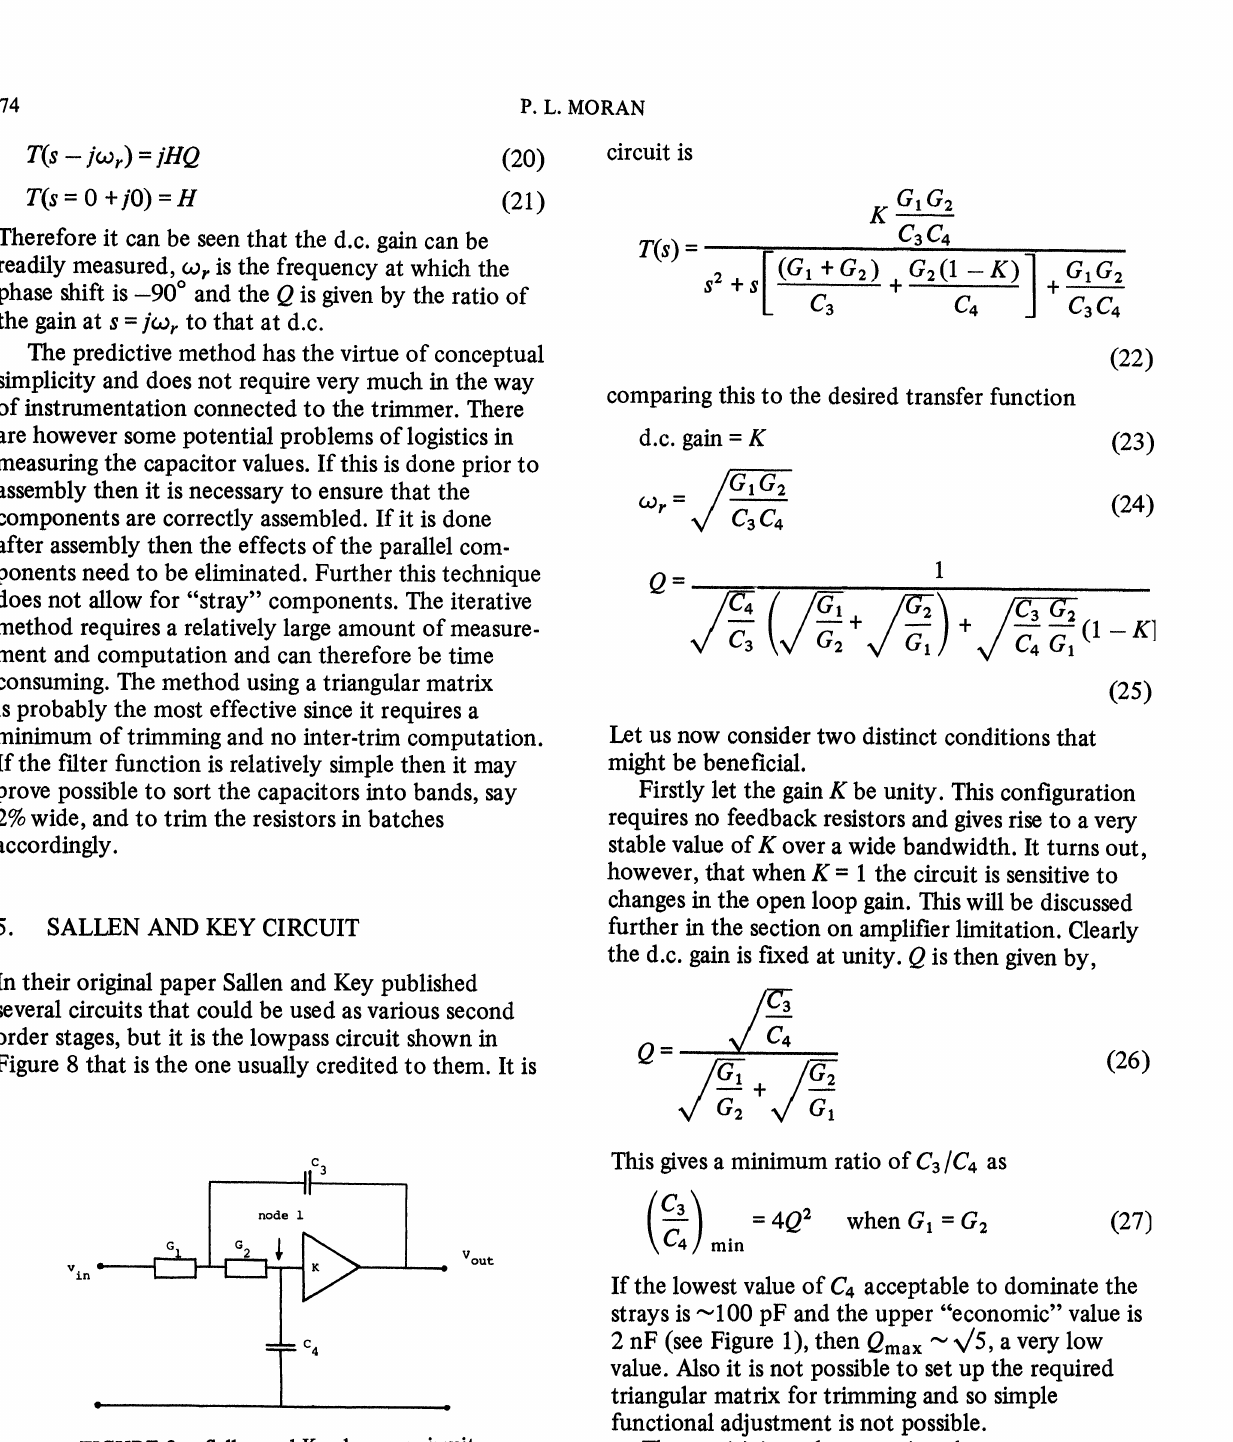
FIGURE 8 Sallen and Key lowpass